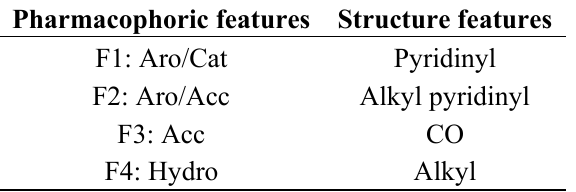
Table 6. Pharmacophoric and structure features of the most active